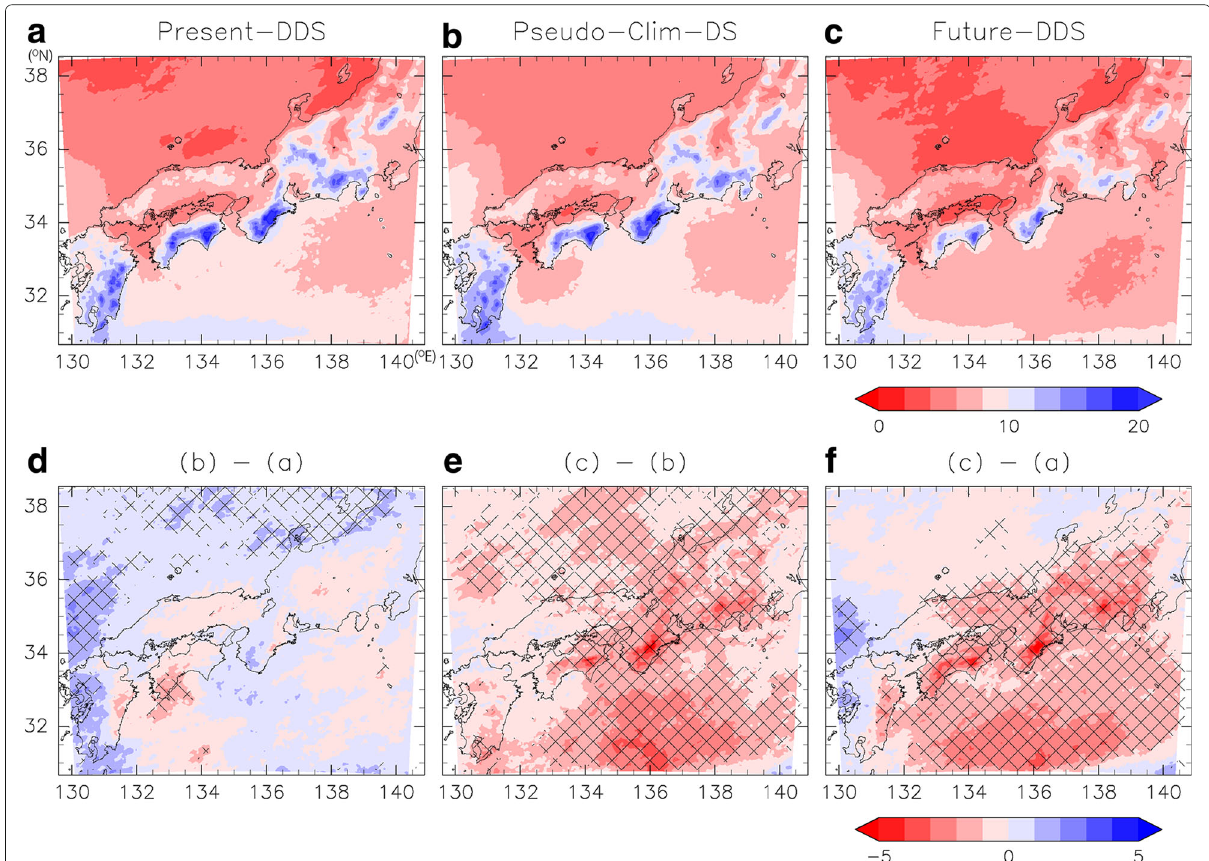
Fig. 3 Horizontal distribution of the 25-year JJAS mean daily precipitation in a the Present-DDS, b Pseudo-Clim-DS, and c Future-DDS runs, and the difference due to d the climate difference (Pseudo-Clim-DS and Present-DDS), e perturbation difference (Future-DDS and Pseudo-Clim-DS), and f total difference (future and Present-DDS runs). The hatched regions in e and f represent the area in which the difference is statistically significant with a 95% confidence level. The unit used is